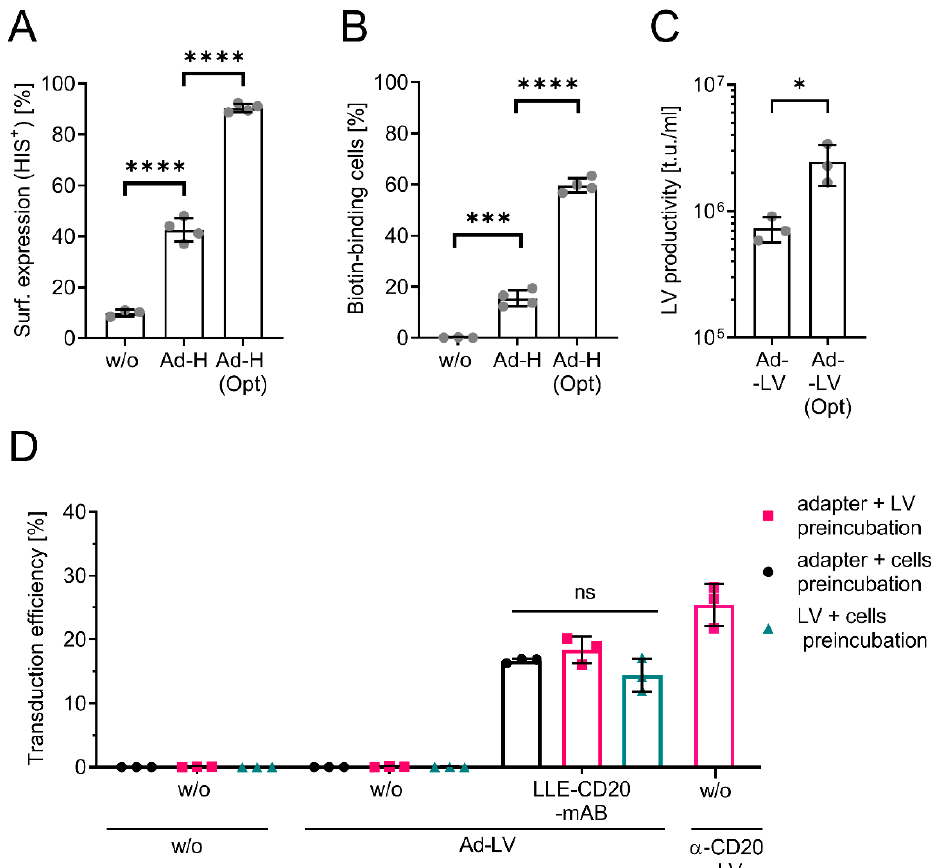
Figure 2. Establishing the Ad-LV system. ( A , B ) Flow cytometric analysis of the surface expression of the H protein fused to the original scFv or a mutant variant (Opt) on HEK293T cells by either staining for the C-terminal HIS-tag ( A ) of the H protein or with fluorescently labeled biotin ( B ) or untreated cells (w/o). Data are represented as mean ± SD of 4 independent experiments. ( C ) LV productivity for concentrated LV supernatant was determined on biotinylated cells. Data are represented as mean ± SD of 3 independent experiments. ( D ) The optimal order of combination of the three components (LVs, cells, and adapter) required for transduction was evaluated via transduction of Raji cells with a GFP-encoding Ad-LV (0.05 TU/cell) using an LLE-CD20-mAB (clone: LT20, 1000 ng/mL). While cells with vector were preincubated for 30 min at 37 °C, cells with adapter or vector with adapter were preincubated for 30 min at 4 °C. Afterwards, the respective third component was added. Transduction without the addition of any adapter (w/o) was used to confirm specificity. MV-LV directly targeting CD20 ( α -CD20-LV) was used as positive control. Transduction efficiency was analyzed 3 days post transduction via quantification of the GFP-positive cells using flow cytometry. Data are represented as mean ± SD of 3 technical replicates. Statistic ordinary one-way ANOVA using Tukey’s multiple comparisons test; ns, non-significant; * p < 0.05, *** p < 0.001, **** p < 0.0001.